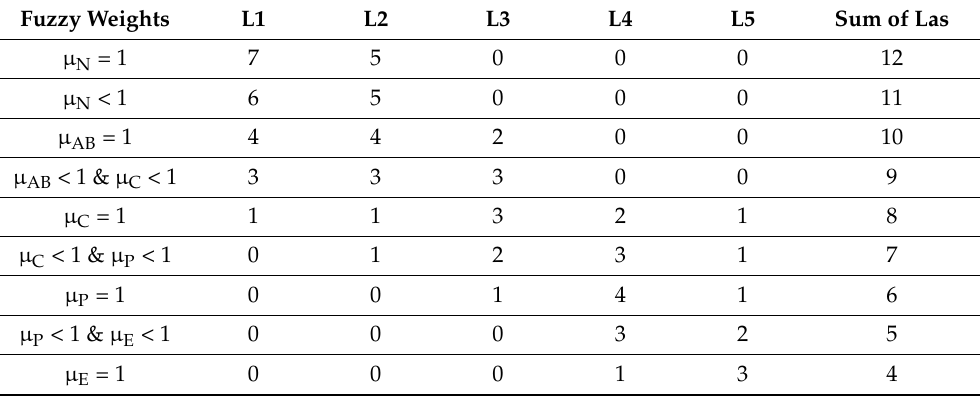
Table 2. Decision rules for adaptive